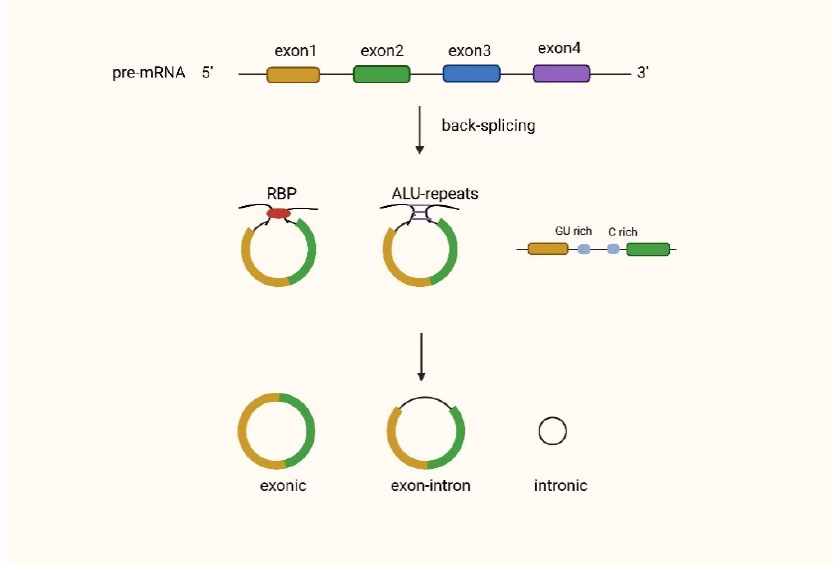
Figure 1. Biogenesis of circRNAs.